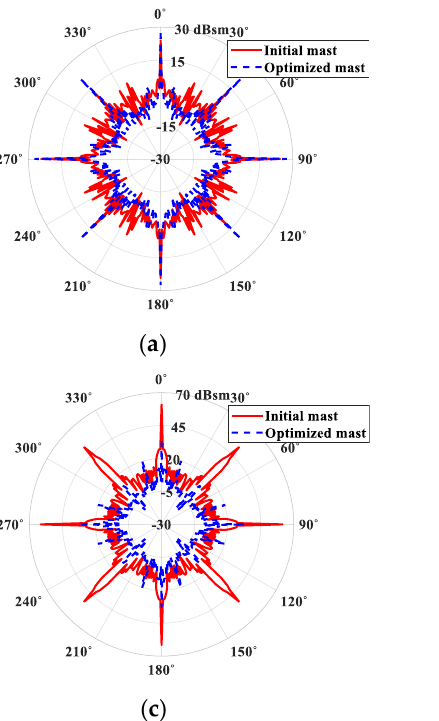
Figure 6. RCS pattern of the integrated mast in the azimuth plane in the L-band. ( a ) HH polarization at an elevation angle